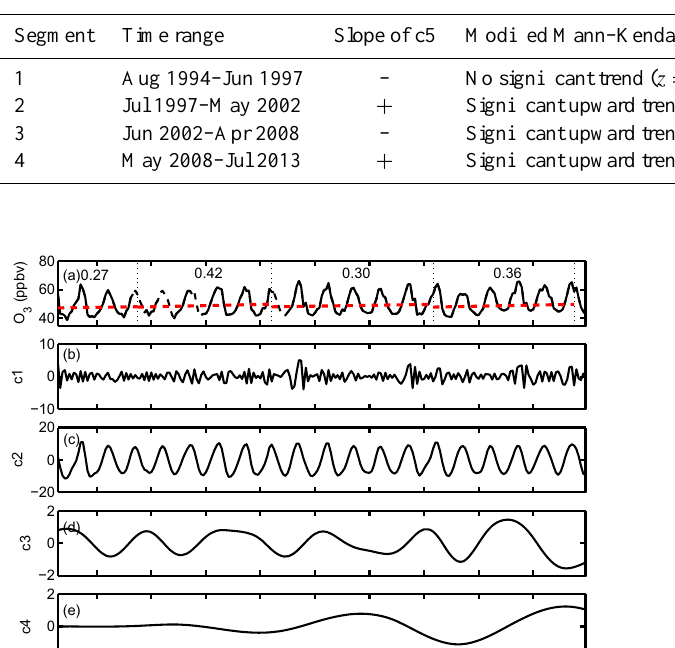
Table 3. Modified Mann–Kendall trend test on segments based on the last IMF.